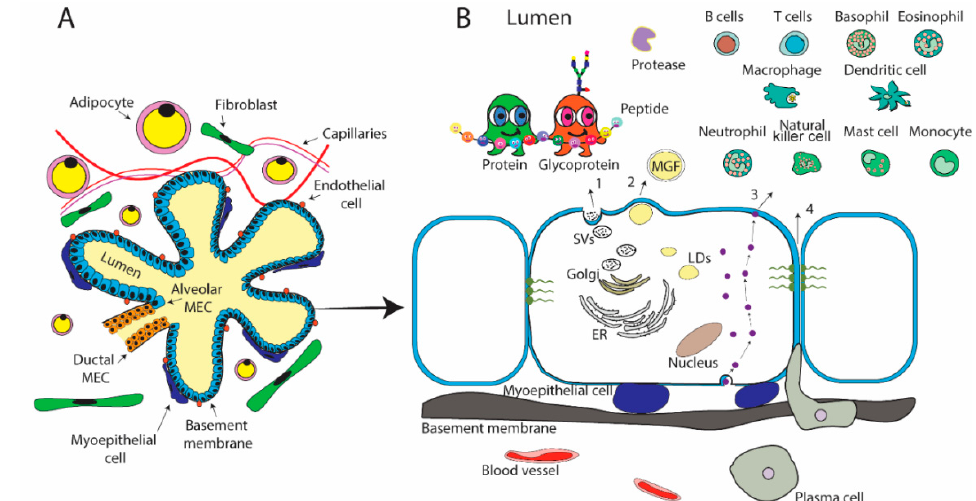
Figure 1. Physiology and transport of the proteome in a lactating mammary gland. ( A ) One lobulo-alveolar cluster connected to a lactiferous duct is depicted. The alveolus cluster, made up of a monolayer of polarized alveolar mammary epithelial cells (MEC) surrounding the lumen, and is connected to the lactiferous duct that is surrounded by a bilayer of ductal MEC. The alveolar MEC are surrounded by basement membrane and a single layer of polarized myoepithelial cells that contract to stimulate milk ejection from the lumen. The alveoli are embedded in a stoma of vascularized connective-tissue that contains lipid-depleted adipocytes, fibroblasts, endothelial cells and capillaries. ( B ) A zoomed in representation of the alveolar MEC is depicted to show the four key transport pathways of the milk proteome. Pathway (1) The exocytotic pathway is the dominant way for the secretion of endogenously generated proteins. These proteins and other aqueous components of milk are transported in secretory vesicles (SVs). Pathway (2) Secretion of lipid-associated proteins by the formation of lipid droplets (LDs), formed in the endoplasmic reticulum (ER), that move to the apical membrane to be secreted as milk fat globule (MFG). MFG are excreted by budding and are enwrapped by the apical plasma membrane of the MEC and become MFGM. Pathway (3) The vesicular transcytosis of proteins from serum or stromal cells. Pathway (4) Direct transport via the paracellular pathway for serum substances and cells, such as immune cells and stem cells. This route of transport is only available during pregnancy, early lactation prior to tight junction closure of MEC, involution, during times of inflammation or preterm birth.